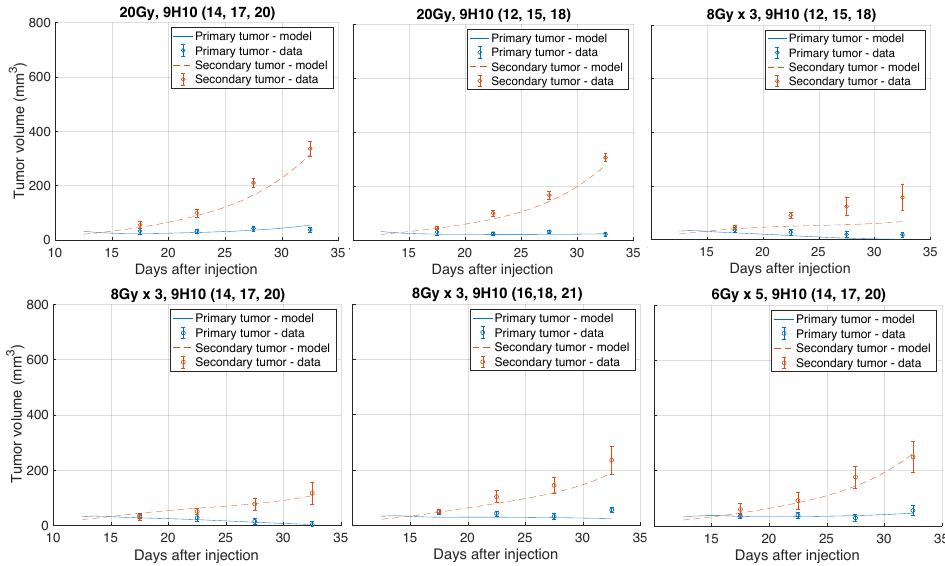
Figure A2. Comparison of model simulated growth dynamics with experimental data. Solutions to the proposed model (lines; Equations (3)–(10)) were obtained after performing data fitting (estimated parameters are presented in Table 1). Shown are experimental and simulated tumor volumes after combination treatment. Experimental data (circles) derived from Dewan et al.